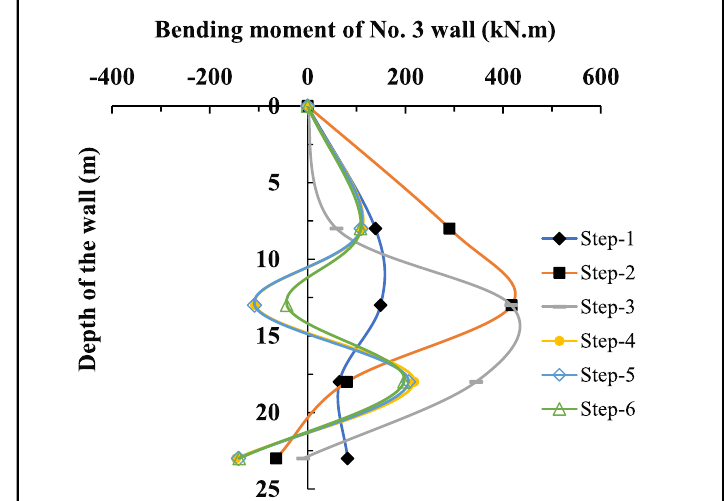
Figure 9. Bending moment of wall No. 3.